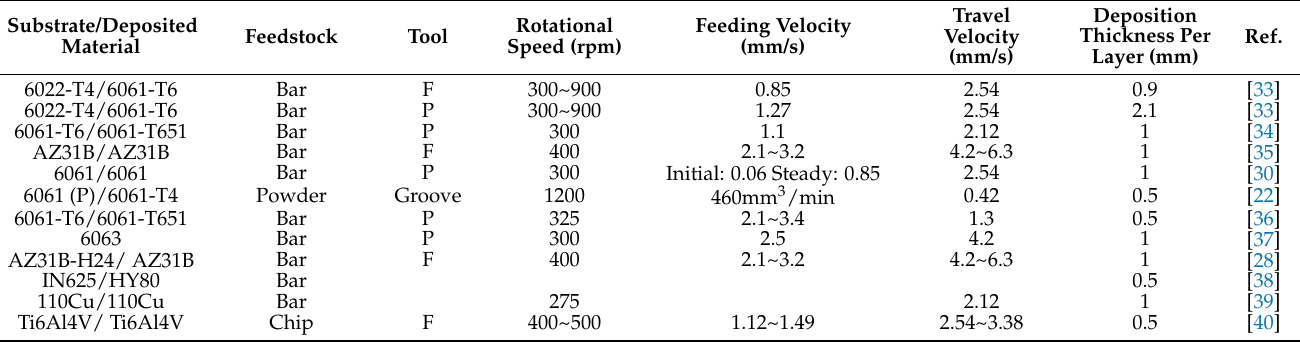
Table 2. Some typical rod-base and powder-base AFSD experiments. P: Protruding; F: flat. Substrate/Deposited Feedstock Material